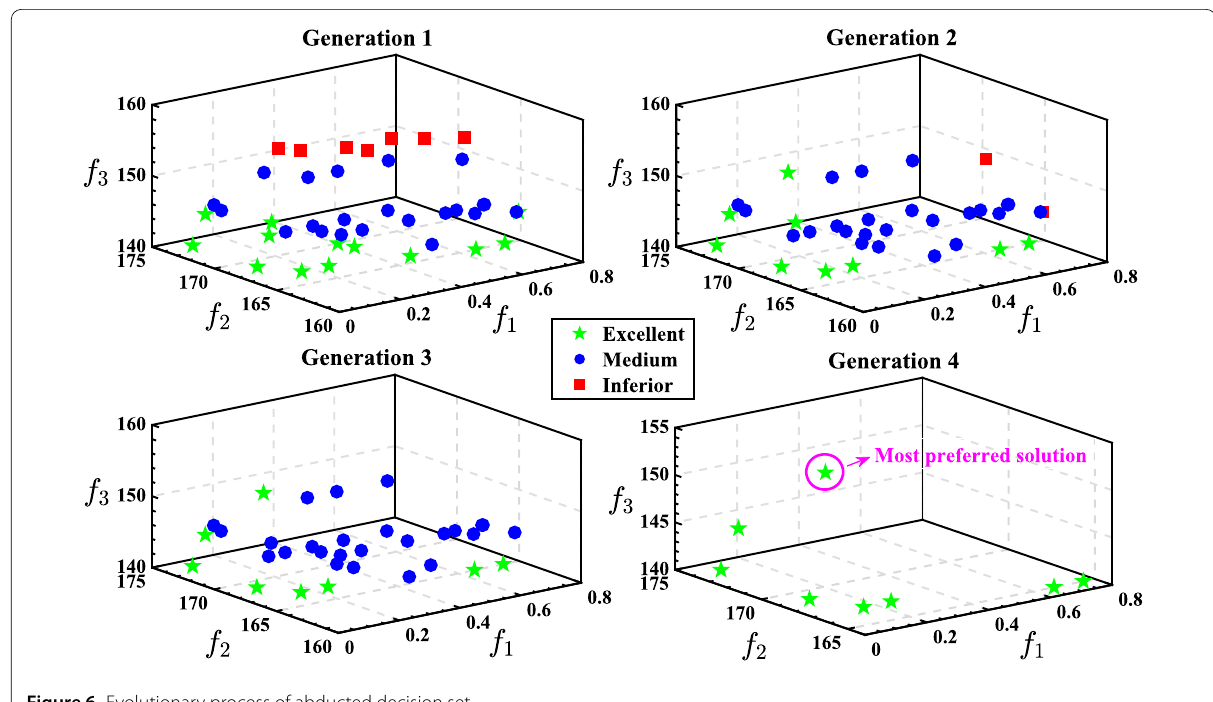
Figure 6 Evolutionary process of abducted decision set